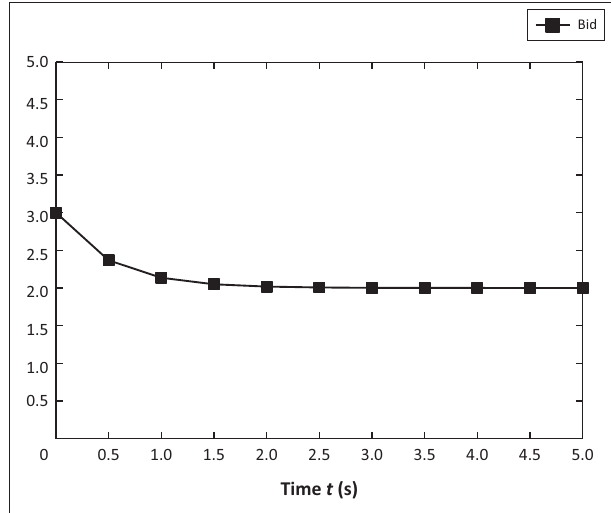
FIGURE 2: Plot of B reverse auction) t ∈ [ t